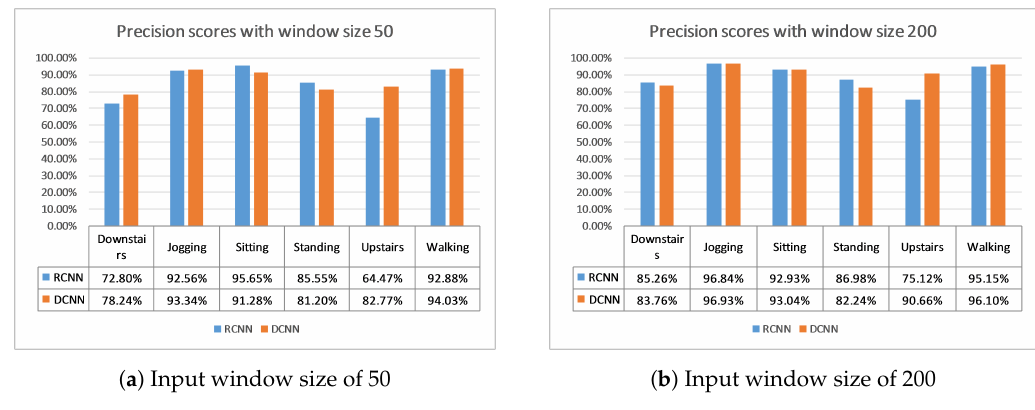
Figure 2. Precision scores on the original train/test split of the WISDM dataset.